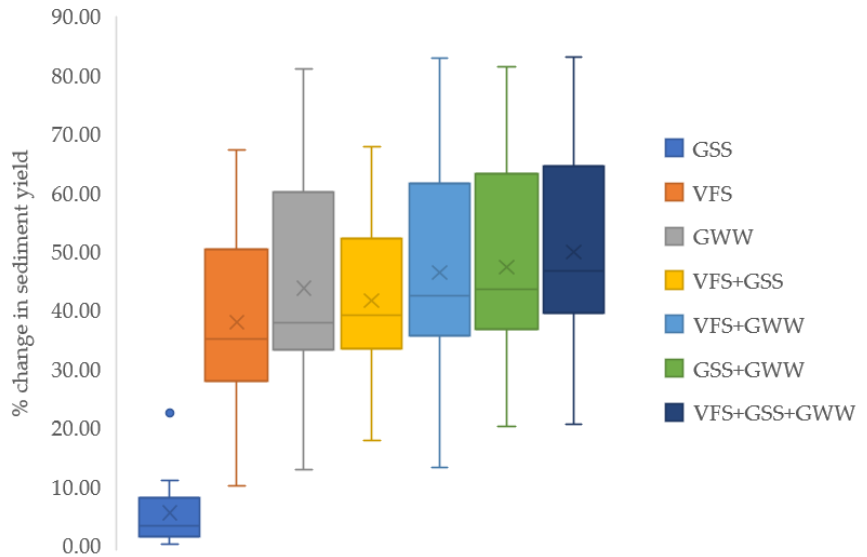
Figure 7. Side-by-side box plot comparing sediment yield reduction range at the sub-watershed level for different scenarios.